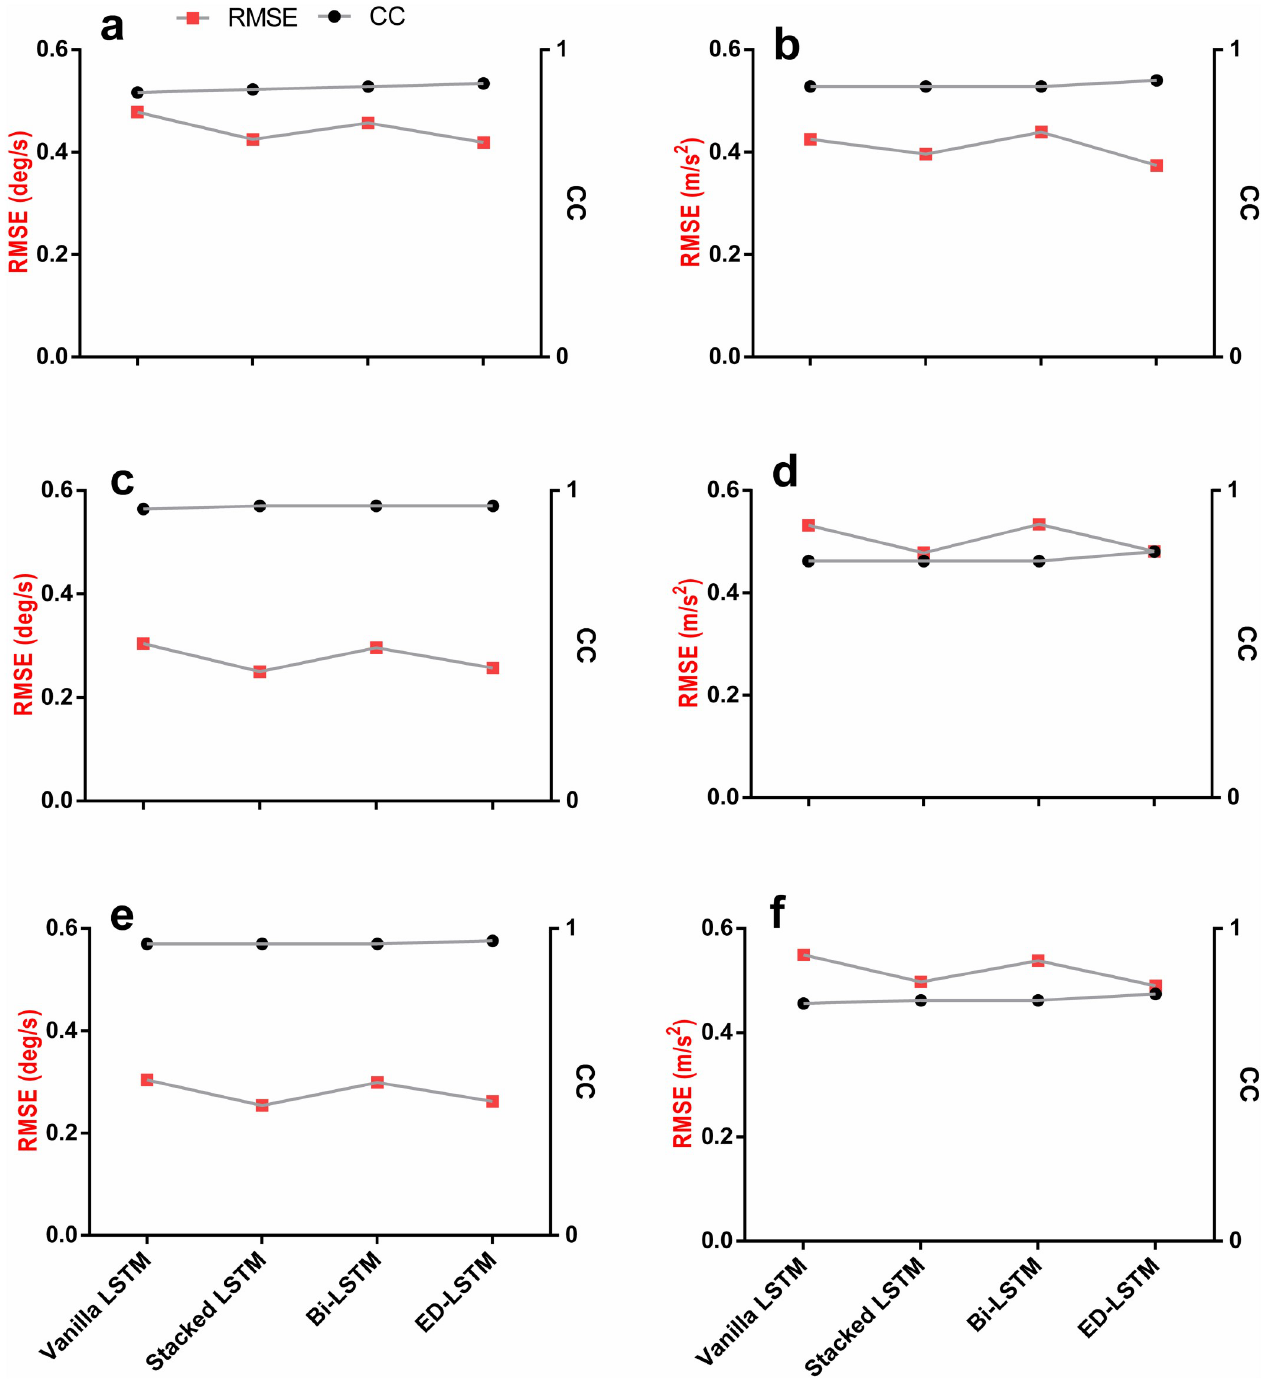
Fig 5. Performance comparison between LSTM models based on leave-one-out cross validation at PWS and 5km.h -1 for each feature vector. Red is the RMSE (Left Y-axis). Black is the CC (Right Y-axis). Wider gaps between the two error lines (CC and RMSE) means better prediction quality for the related feature vector. The Stacked and ED LSTM maintained the gap for all feature vectors. (a) Foot AV ( X 1 ). (b) Foot LA ( Y 4 ). (c) Shank AV ( X 2 ). (d) Shank LA ( Y 5 ). (e) Thigh AV ( X 3 ). (f) Thigh LA ( Y 6